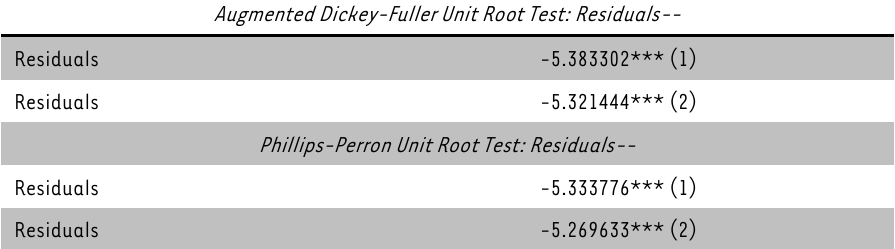
TABLE 5: Unit root tests on Residuals-Negative Component of oil prices